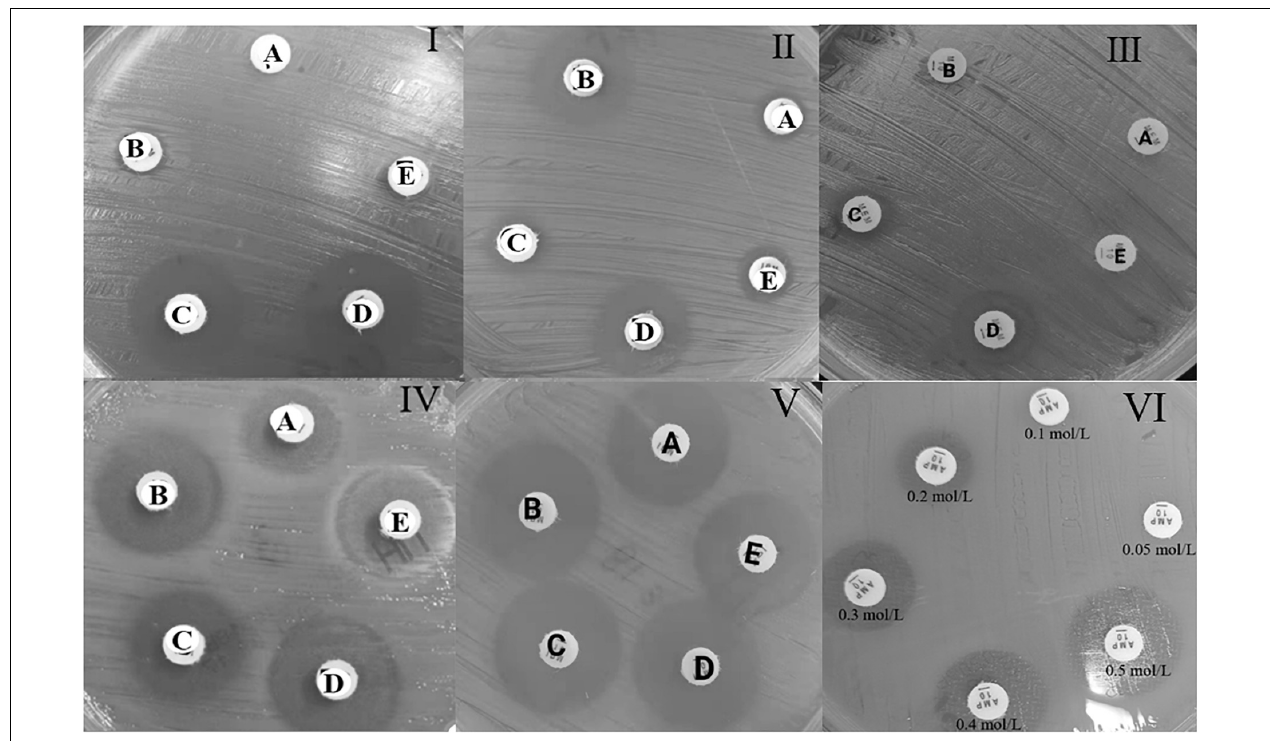
FIGURE 1 | Example of the carbapenemase and AmpC enzyme detection test with reading at 4 h, for the rsCDM test. A, imipenem; B, imipenem + APBA; C, imipenem + EDTA; D, imipenem + APBA + EDTA; E, imipenem + CLO. MBL carbapenemase (I) , KPC carbapenemase (II) , KPC and MBL carbapenemase (III) , AmpC with porin changes (IV) , ESBL enzyme (V) , EDTA negative control (VI) .